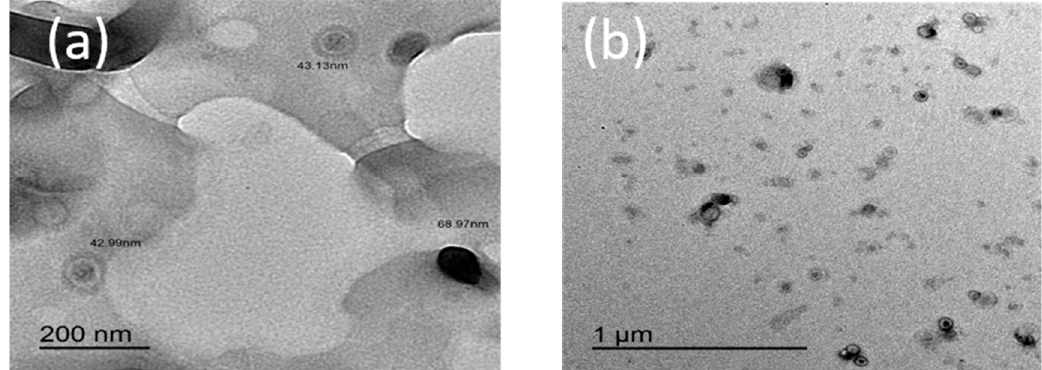
Figure 4. TEM images of Hap/CS nanocomposite: ( a ) 200 nm; ( b ) 1 µm.